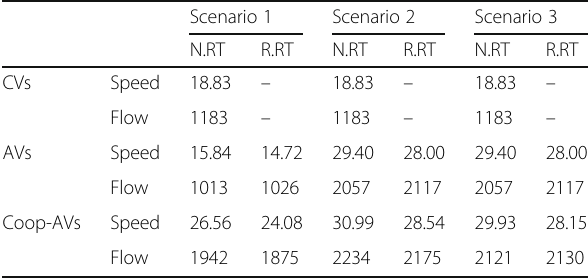
Table 2 Average results for speed and flow per vehicle type, scenario and response speed. Abbreviations N.RT and